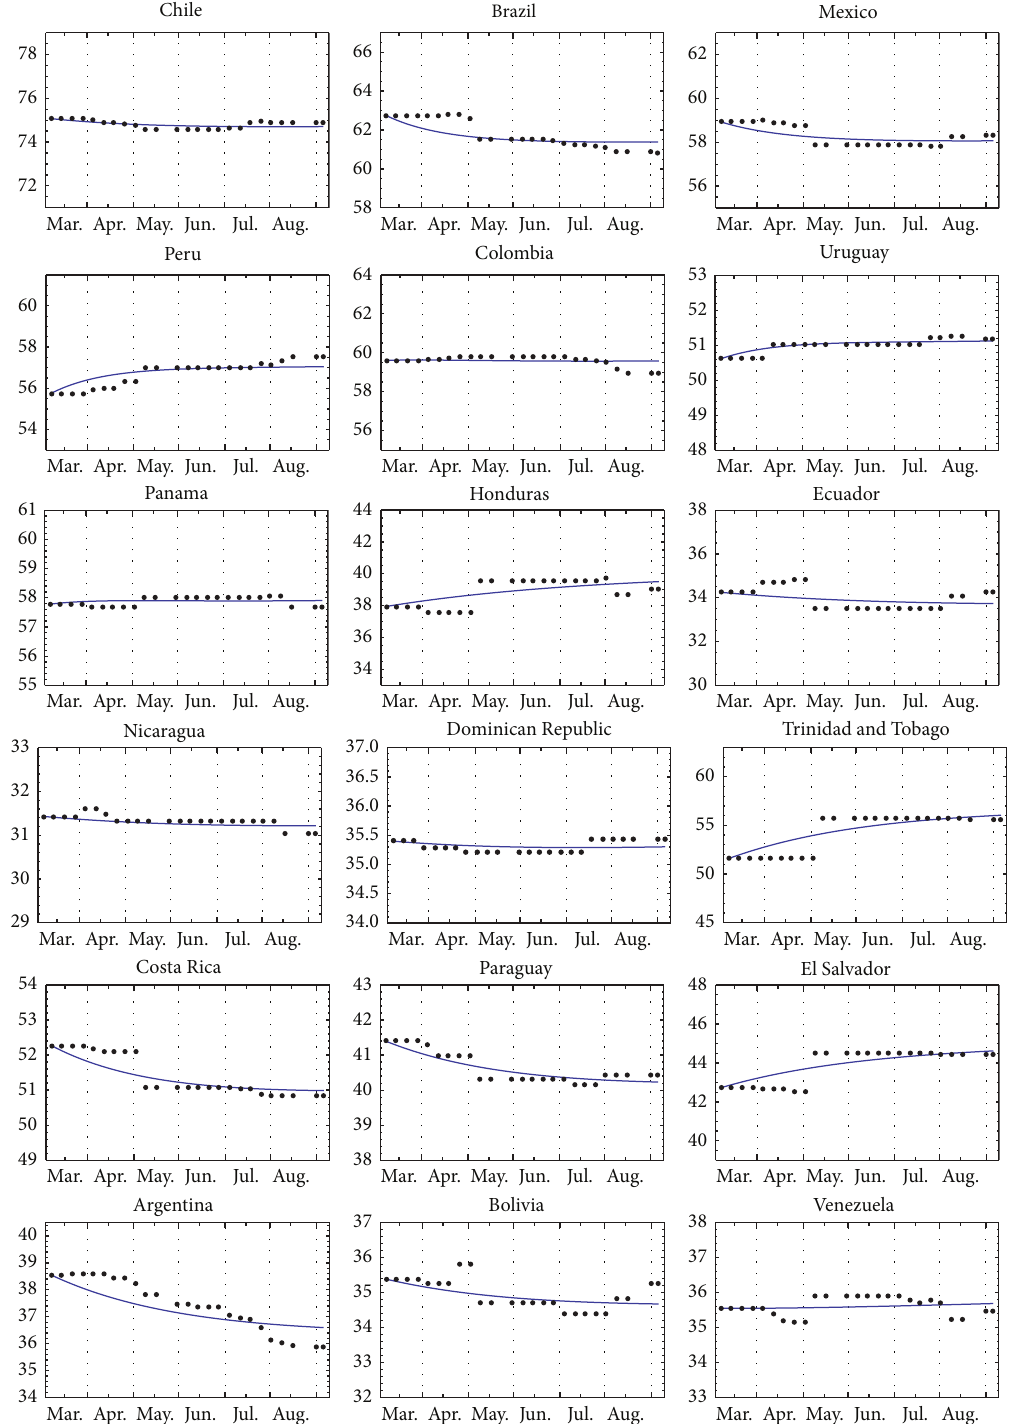
Figure 4: CRS fitting for the 18 selected Latin American countries. The solid line is the model solution for the parameters of Tables 3 and 4 that best fit the model. The points are the known CRS data from February 6, 2012, to August 6, 2012. Notice the different vertical scales in the plots for each